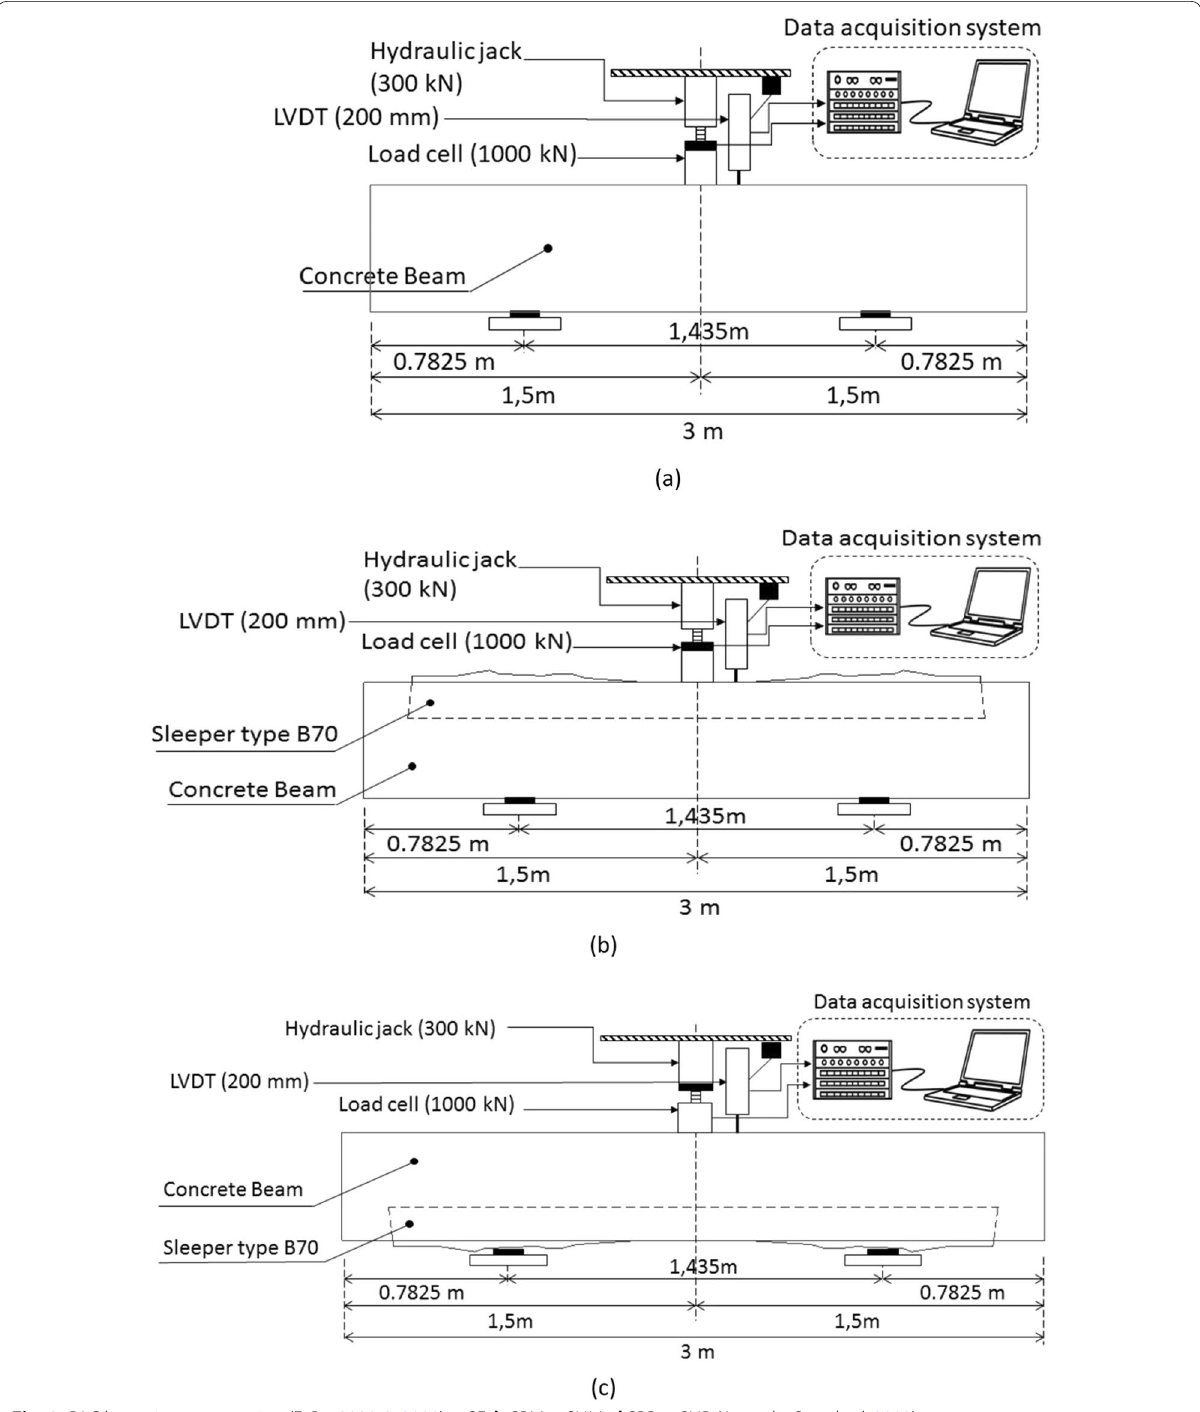
Fig. 8 PAC beam instrumentation (E. B. 13230-2, 2009): a SE, b SPM, c SNM, d SPR, e SNR (Australia Standard,